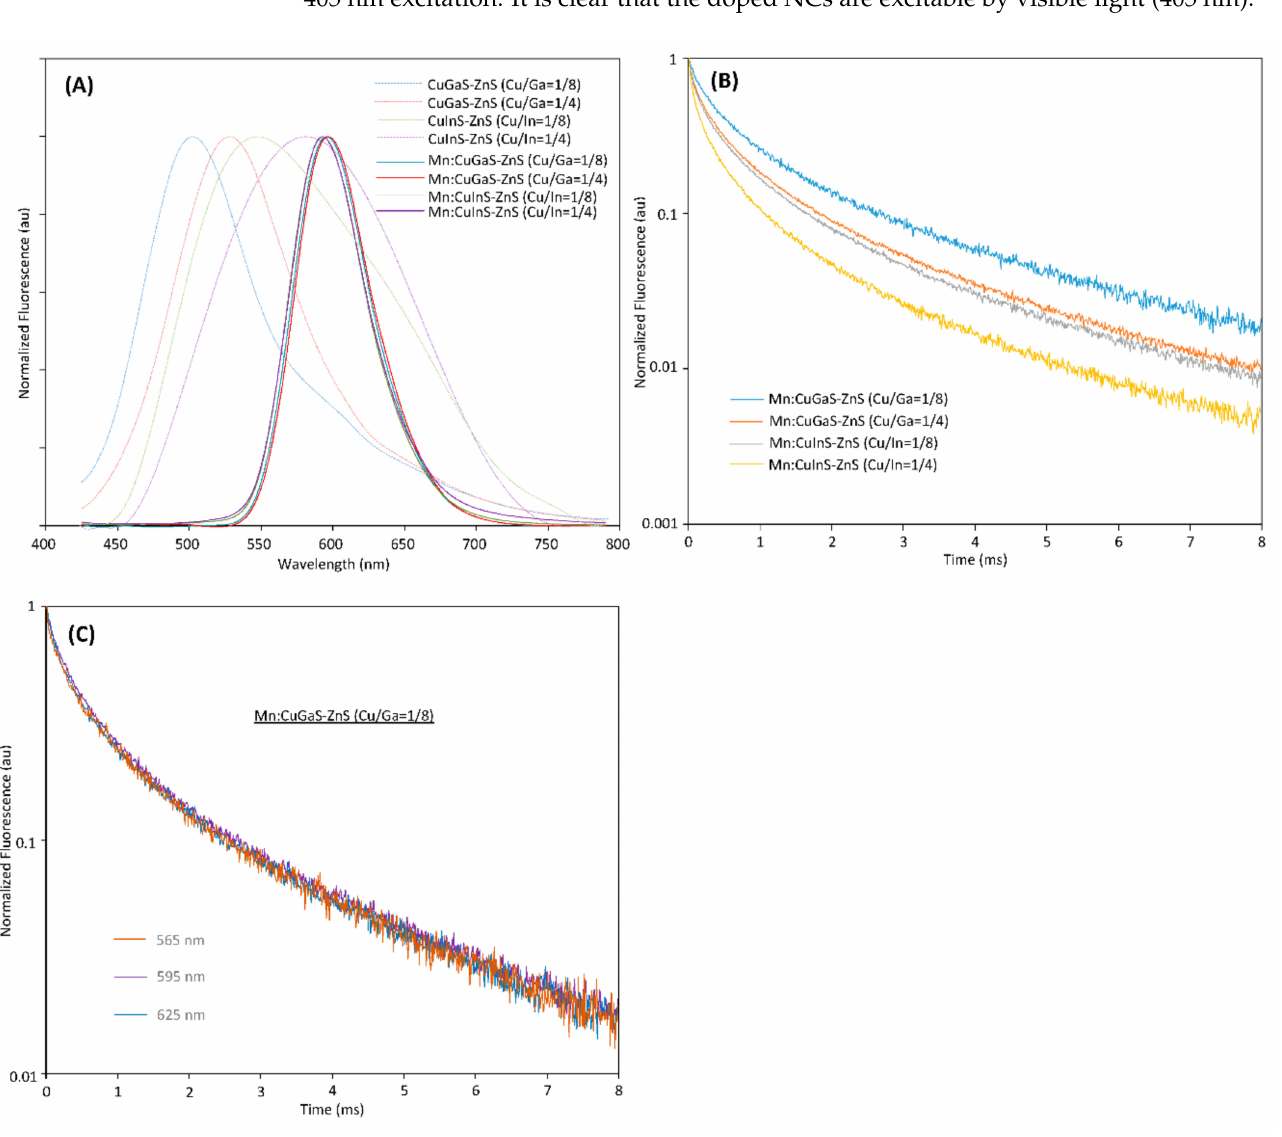
Figure 1. ( A ) Fluorescence spectra of four types of host NCs and four types of Mn-doped NCs (0.0125 mmol Mn-doped into each type of host NCs). ( B ) Fluorescence decays for four types of Mn-doped NCs (measured at 595 nm for all NC samples). ( C ) Fluorescence decays of Mn:CuGaS-ZnS (Cu/Ga = 1/8) NCs at 565, 595 and 625